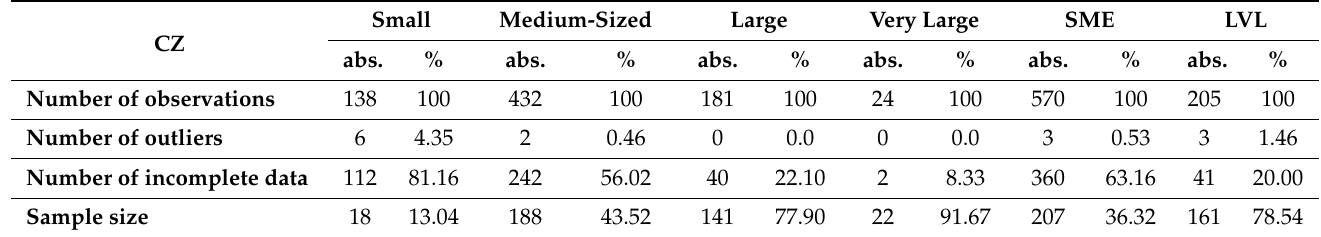
Table 9. The final sample of the Czech companies in the transport